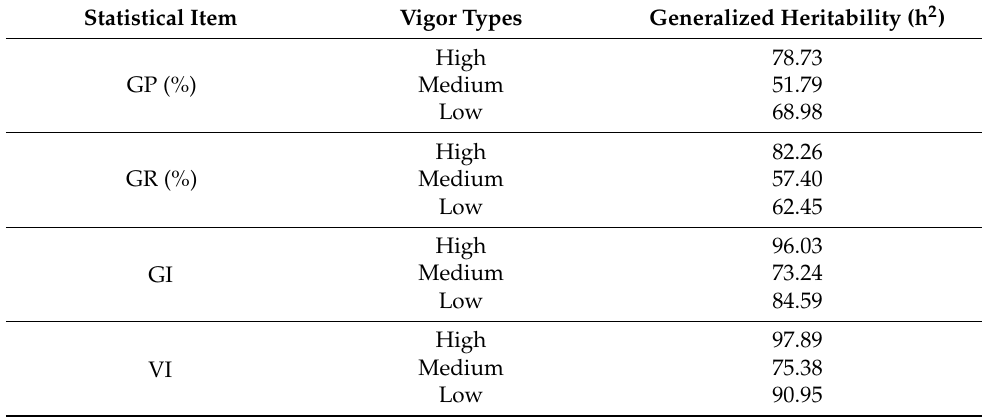
Table 8. Generalized heritability analysis of the seed vigor of strains of different vigor